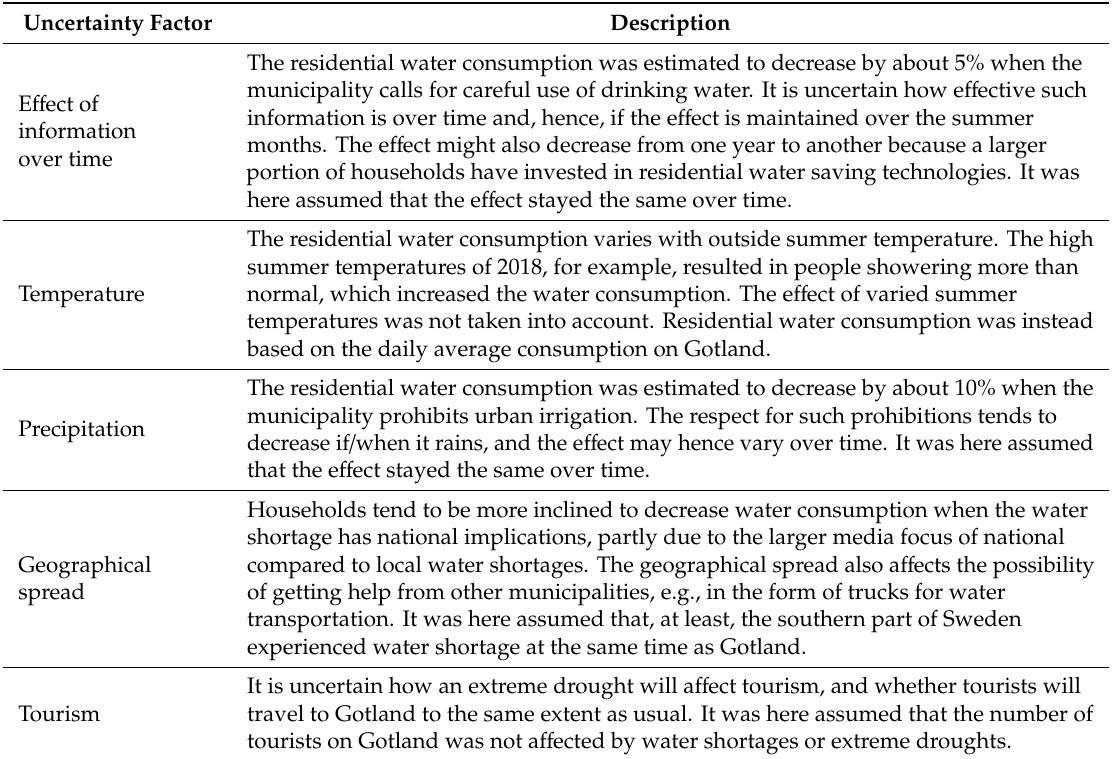
Table 4. Non-quantified uncertainty factors discussed at the She ffi eld Elicitation Framework (SHELF)